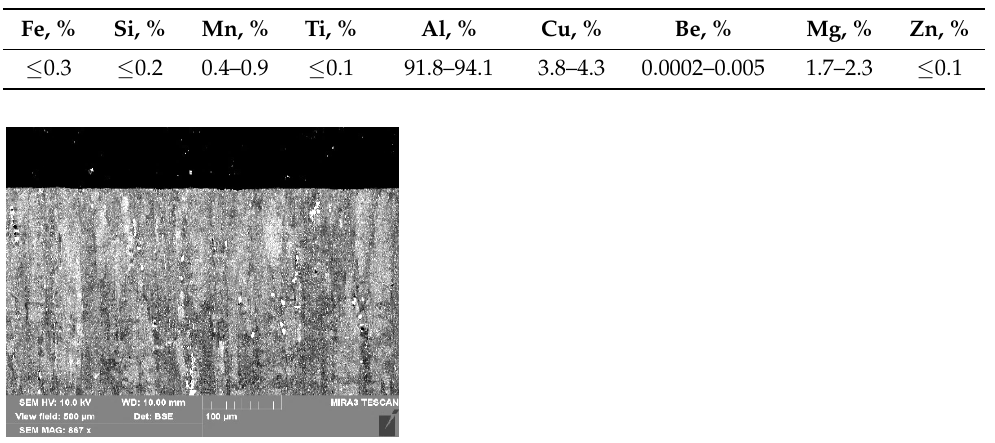
Figure 3. Diagram of sample positioning system in chamber of cavitation jet test rig.